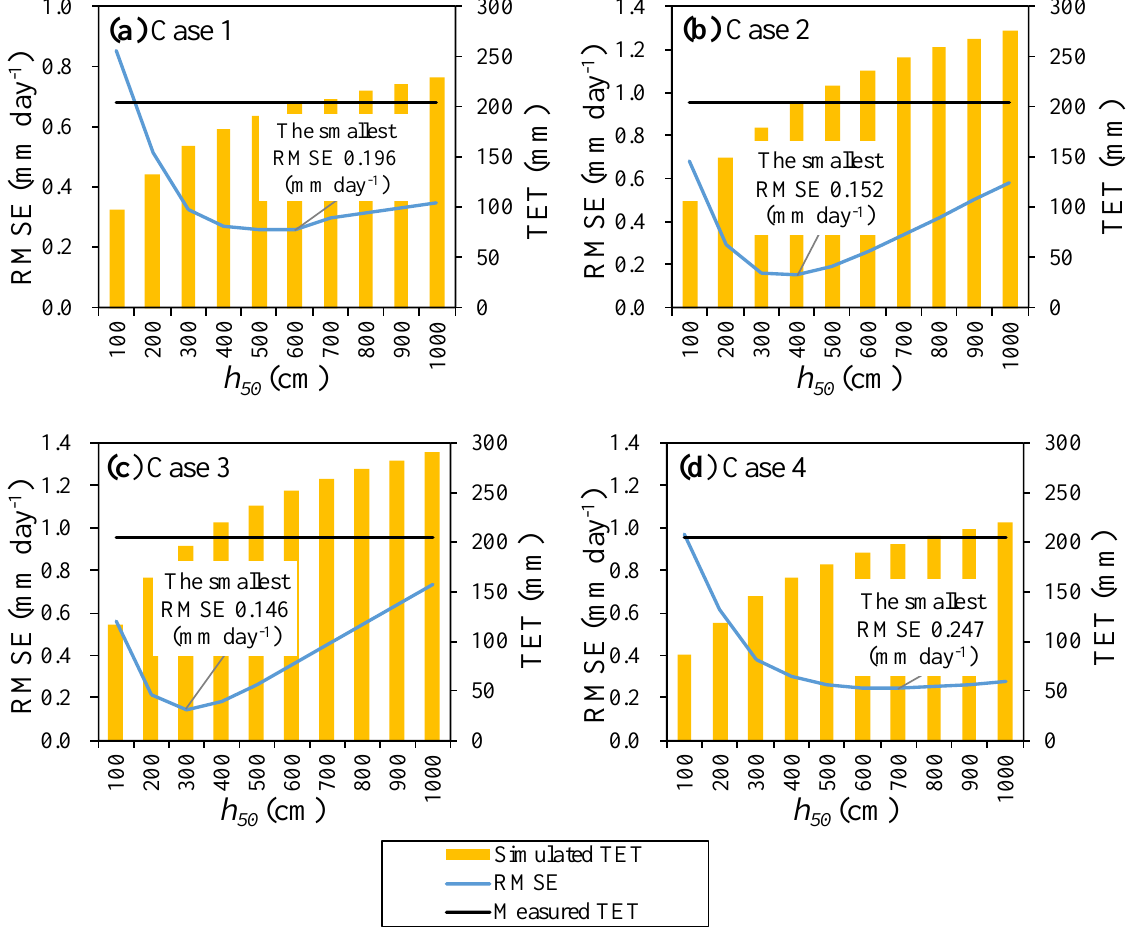
Figure 5. Relationships of the value of h ( b ) Case 2; ( c ) Case 3; ( d ) Case